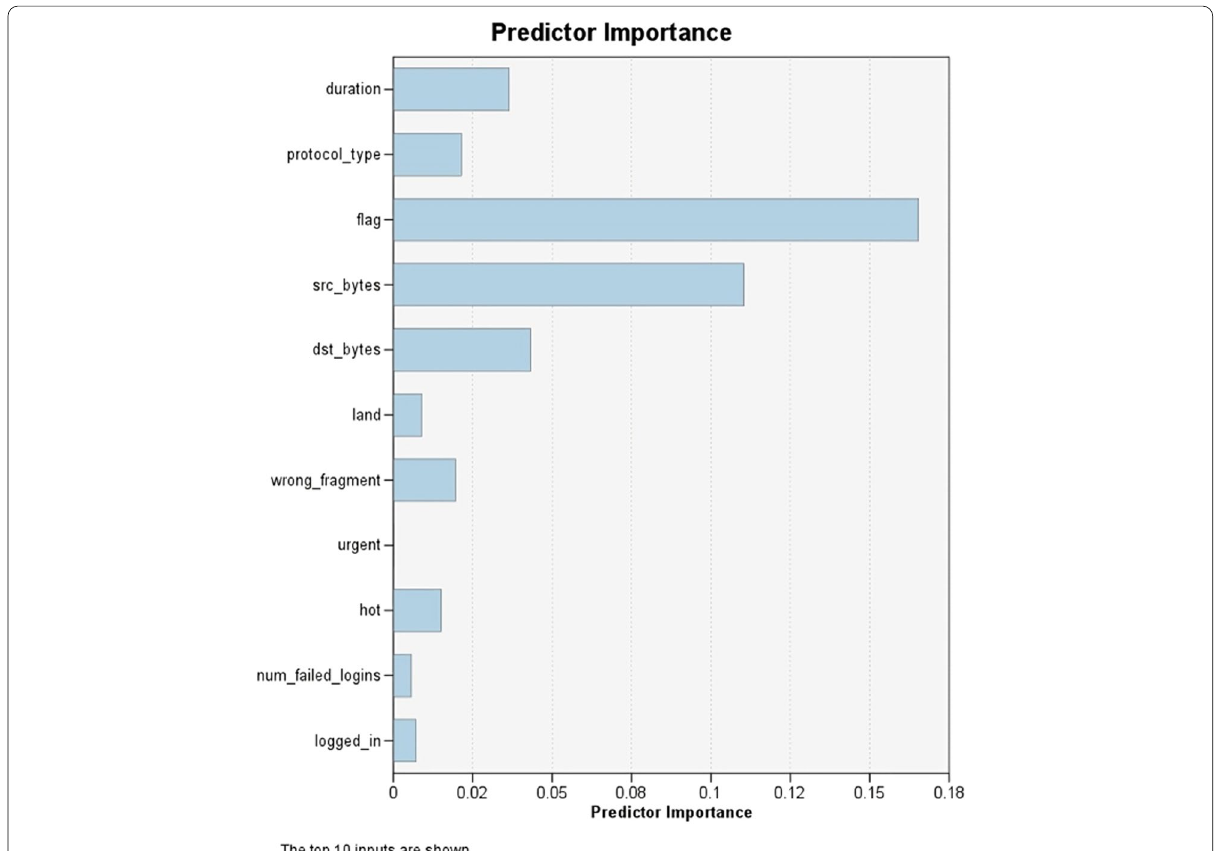
Fig. 2 Random Tree model